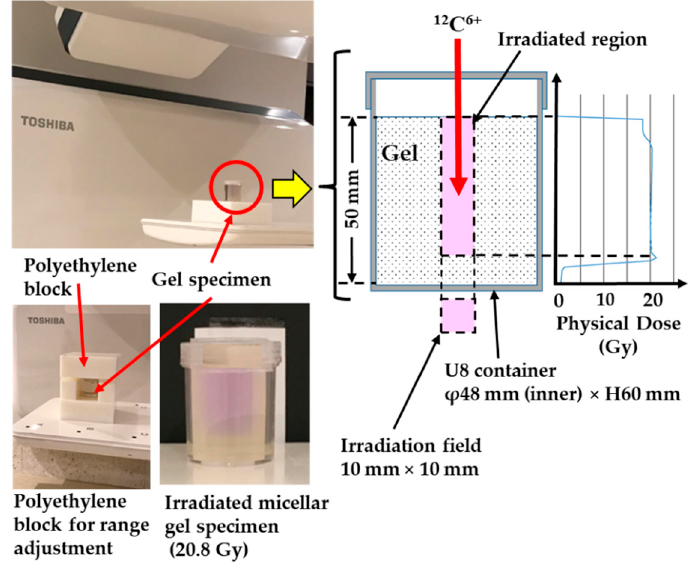
Figure 2. Setup of the gel specimen, irradiation geometry, and physical dose distribution. Table 2. Experimental conditions.